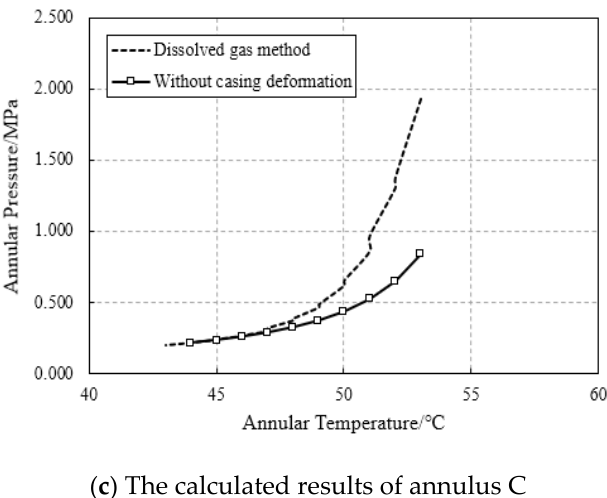
Figure 13. Simulation results without consideration of casing